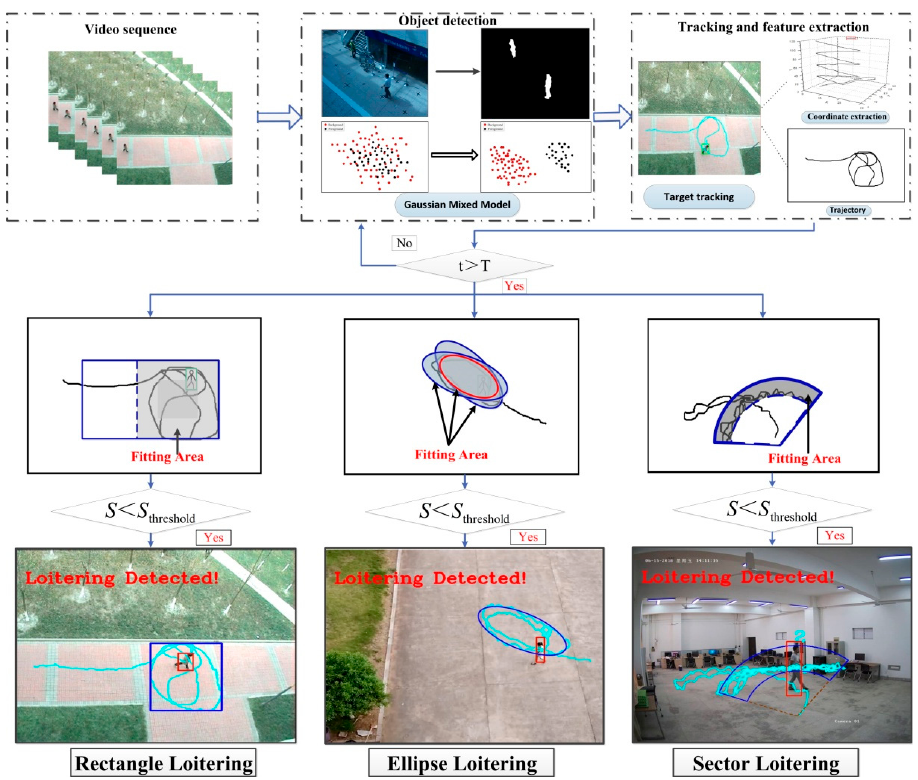
Figure 1. The overall framework of loitering detection method.